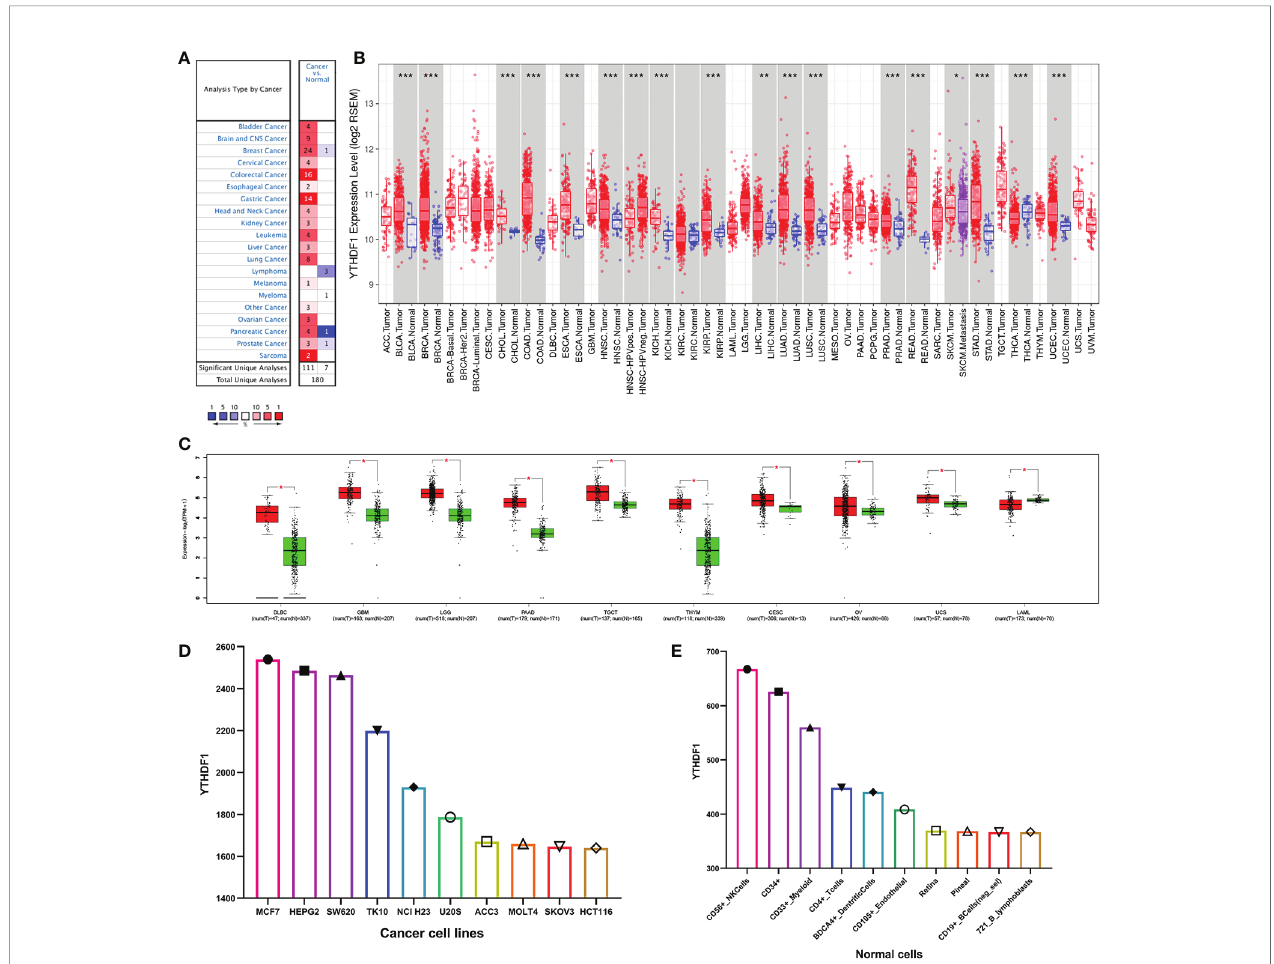
FIGURE 1 | YTHDF1 expression levels in human cancers. (A) YTHDF1 expression in different cancers and paired normal tissue in the Oncomine database. (B) YTHDF1 expression levels in different cancer types from the TCGA database analyzed by the TIMER database. (* P < 0.05, ** P < 0.01, *** P < 0.001). (C) YTHDF1 expression in several cancers and paired normal tissue in the GEPIA database. (D) the expression of YTHDF1 in different cancer cell lines analyzed by the BioGPS database. (E) the expression of YTHDF1 in normal tissue analyzed by the BioGPS